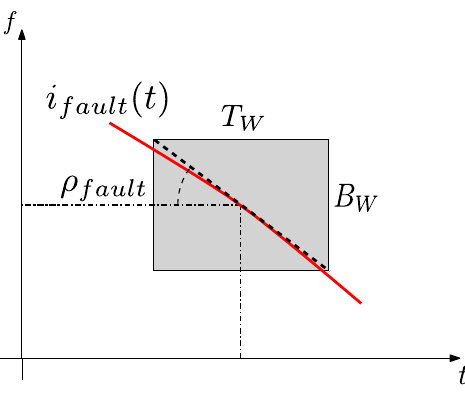
Figure 2. Choice of the parameters of the Slepian window so that the aspect ratio of its Heisenberg box coincides with the slope of the trajectory of the related fault component in the time-frequency (TF)